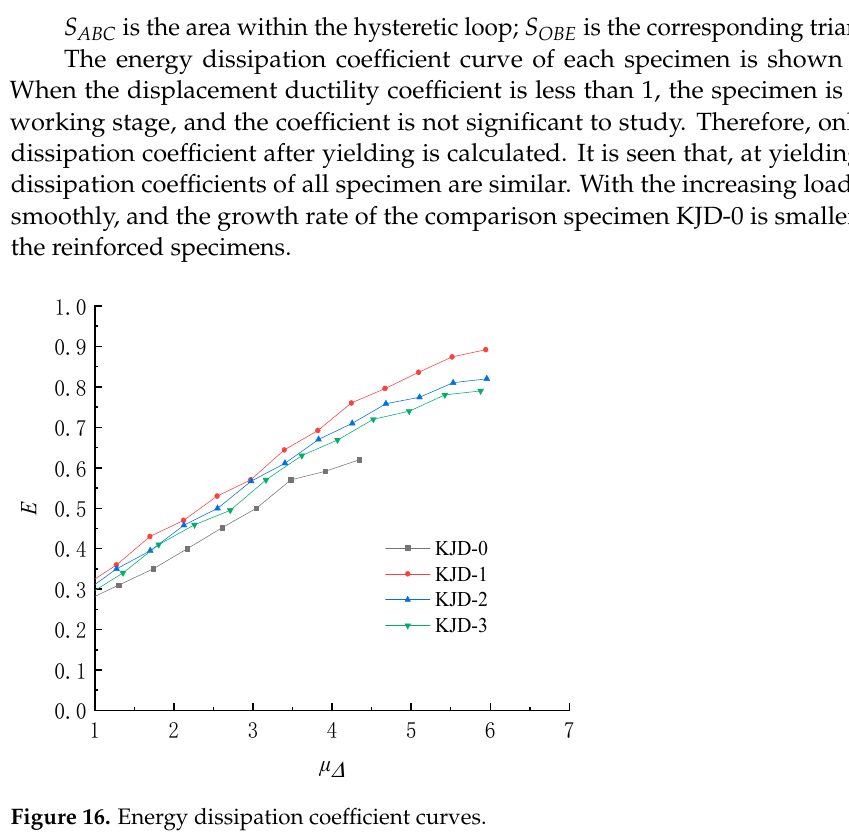
Figure 16. Energy dissipation coefficient curves.